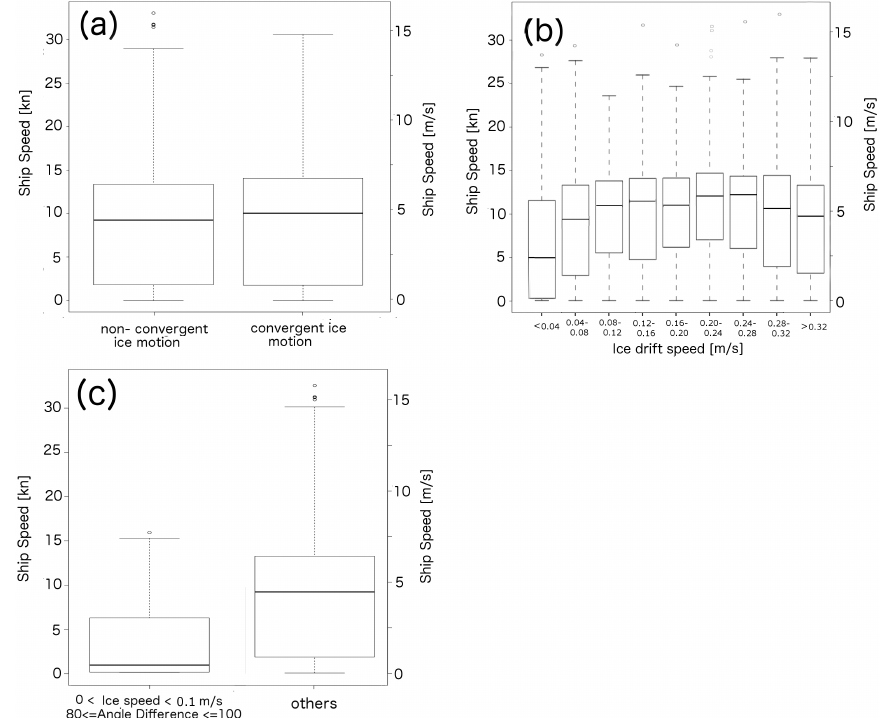
Figure 6. (a) – (c) The distribution of observed ship speeds under various ice-related factors. As in Fig. 5 the respective distribution of ship speeds is depicted by box plots. (a) refers to convergent and nonconvergent ice motion, (b) explores various classes of ice drift speed and (c) refers to the specific situation where the ice is drifting very slowly ( < 0.1ms − 1 ) and, additionally, the ice drift angle is close to 90 ◦ relative to the ship course. (Naturally, only data sets with ship and ice speeds > 0 could be